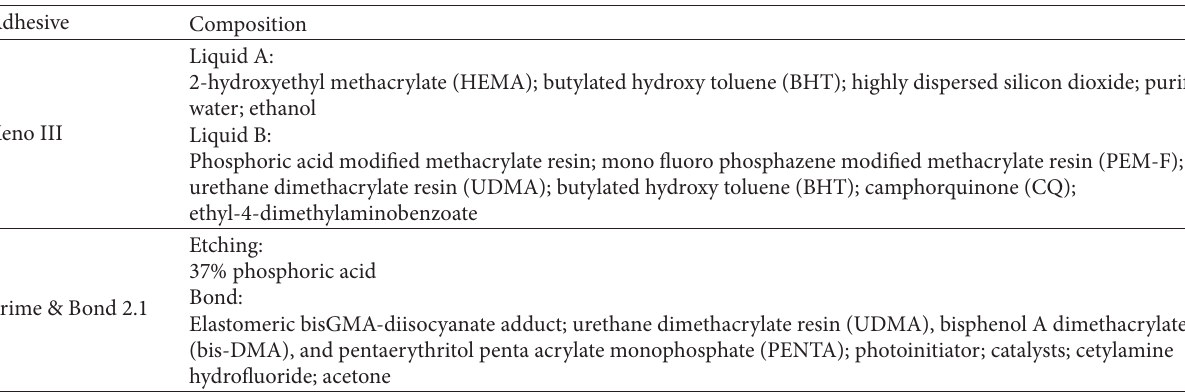
T 1: Composition of the adhesives systems tested.